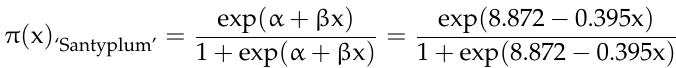
Figure 3. Temporal evolution of the marketability probability based on days of storage for the ‘Angelle’, ‘Genio’, ‘Dolchettini’, and ‘Santyplum’ cultivars.